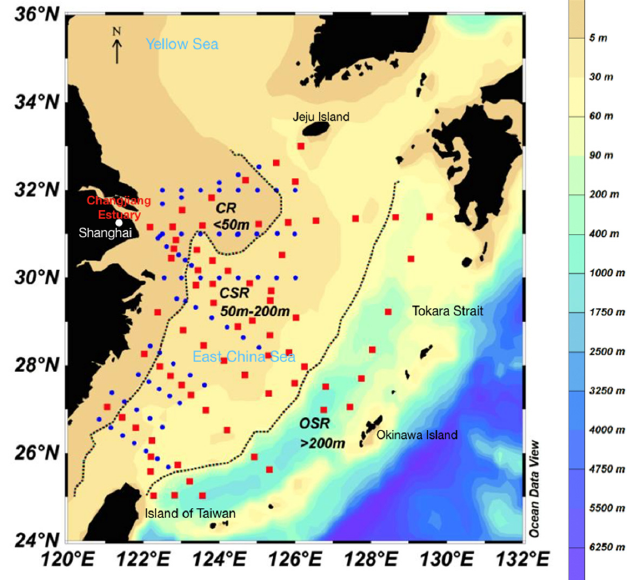
Figure 1. Study area and locations of POC sampling stations in ECS. The study area is divided into three regions by the dashed lines, including the coastal region (CR, <50 m water depth area); the continental shelf region (CSR, 50–200 m water depth area); and the open sea region (OSR, >200 m water depth area). Blue dots represent in situ observational stations in 2011 and red square represent stations of published data.